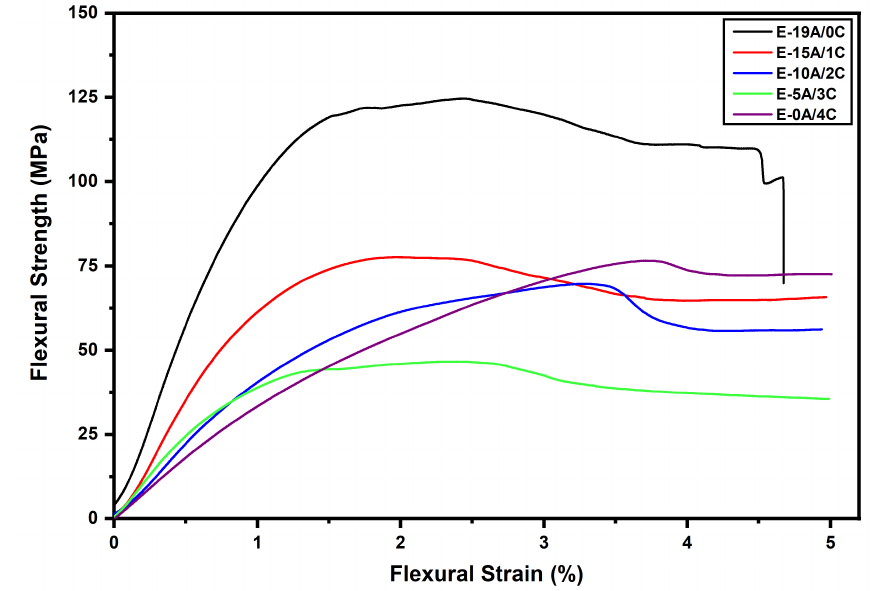
Figure 2. Stress–strain curves of three-point flexural